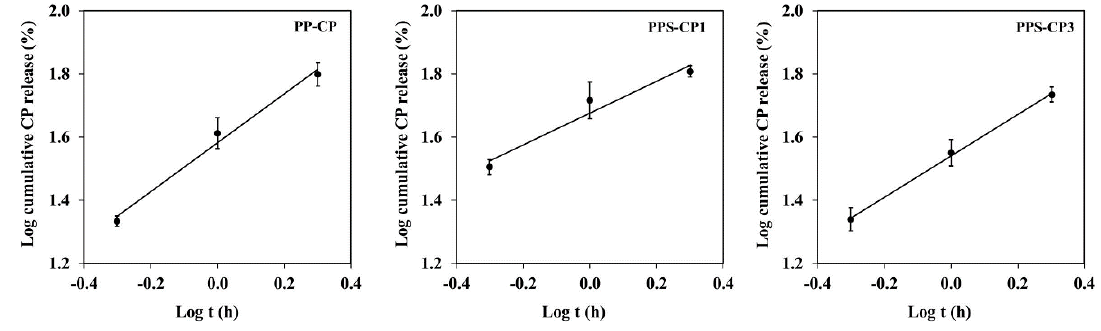
Figure 6. Kinetic plots of CP release according to the Korsmeyer–Peppas model. Table 4. Release kinetics parameters from different kinetic models.